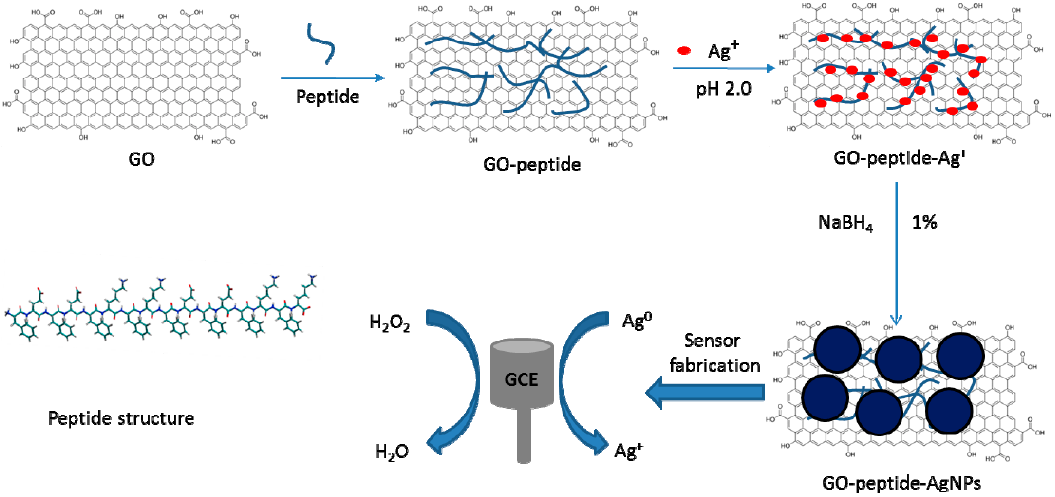
Figure 1. Schematic presentation on the peptide-mediated biomimetic synthesis of GO–peptide–AgNPs nanohybrids. For the preparation of GO–peptide–AgNPs nanohybrids modified GCE, 0.1 mL